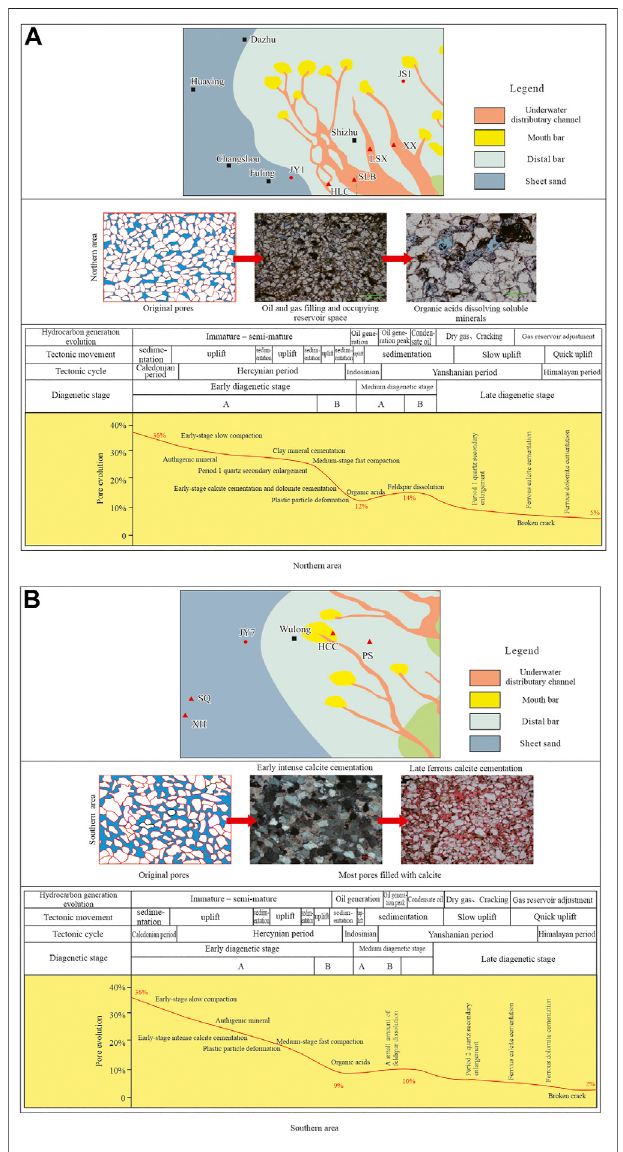
FIGURE 17 | Inhomogeneous sedimentation — diagenesis — reservoir formation mode of the Xiaoheba Formation in Southeast Sichuan; (A) Northern area; (B) Southern